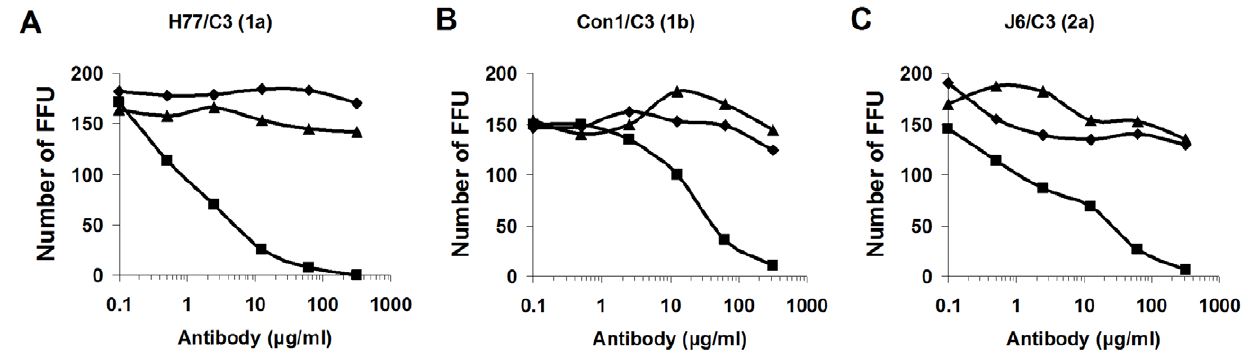
Figure 6. Neutralization assay by FFU reduction. The mean numbers of positive foci are shown for viruses H77/C3 ( A ), Con1/C3 ( B ), and J6/C3 ( C ). Compared to the results obtained with an irrelevant control antibody, # 55 inhibited the viral infection in dose-dependent manner for all of the 3 samples tested. Inhibition by # 37 was not observed. ¤ , control; & , # 55; m , # 37.